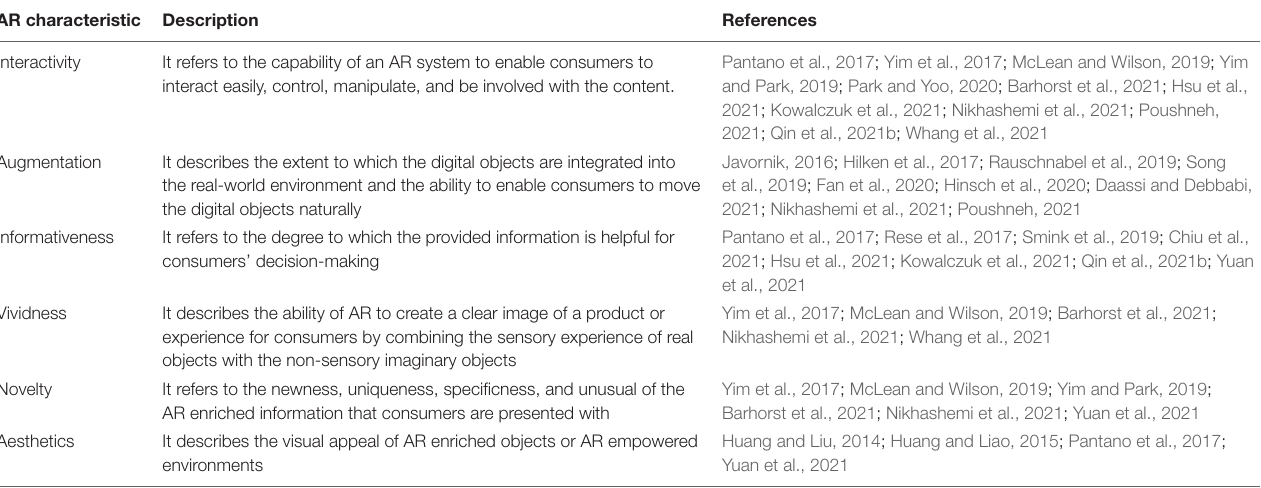
TABLE 5 | Augmented reality characteristics examined in the literature on AR in